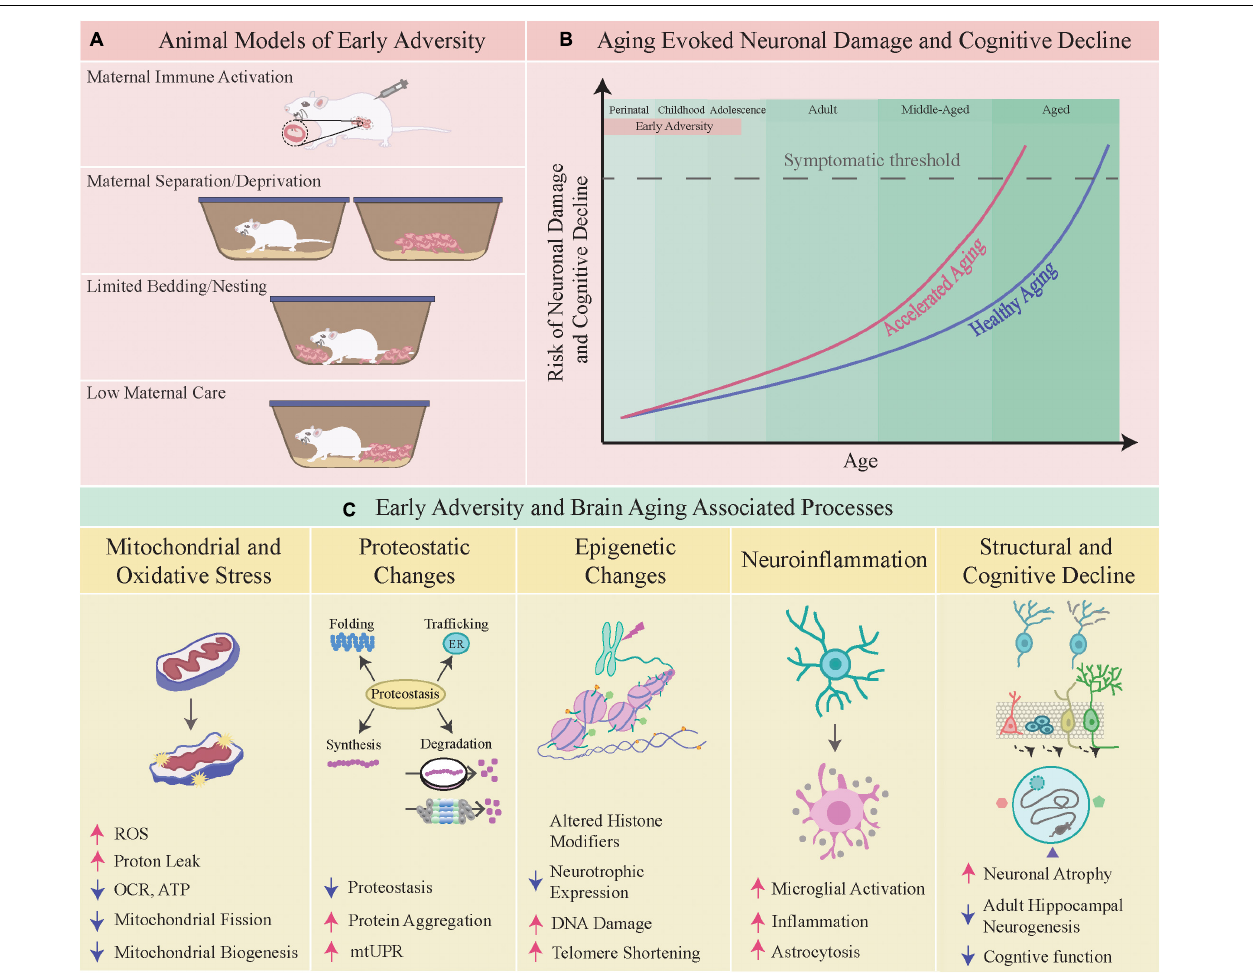
FIGURE 1 | Early adversity and brain aging-associated processes. (A) Shown here are specific animal models of early adversity viz. maternal immune activation, maternal separation/deprivation, limited bedding and nesting, and low maternal care. (B) The schematic depicts the hastening of brain aging and an earlier onset of neuronal damage and cognitive decline following early adversity. (C) Depicted below are some of the aging-associated processes that are perturbed by early adversity, namely the following physiological mechanisms viz. mitochondrial homeostasis, proteostasis, epigenetics, neuroinflammation, structural and cognitive